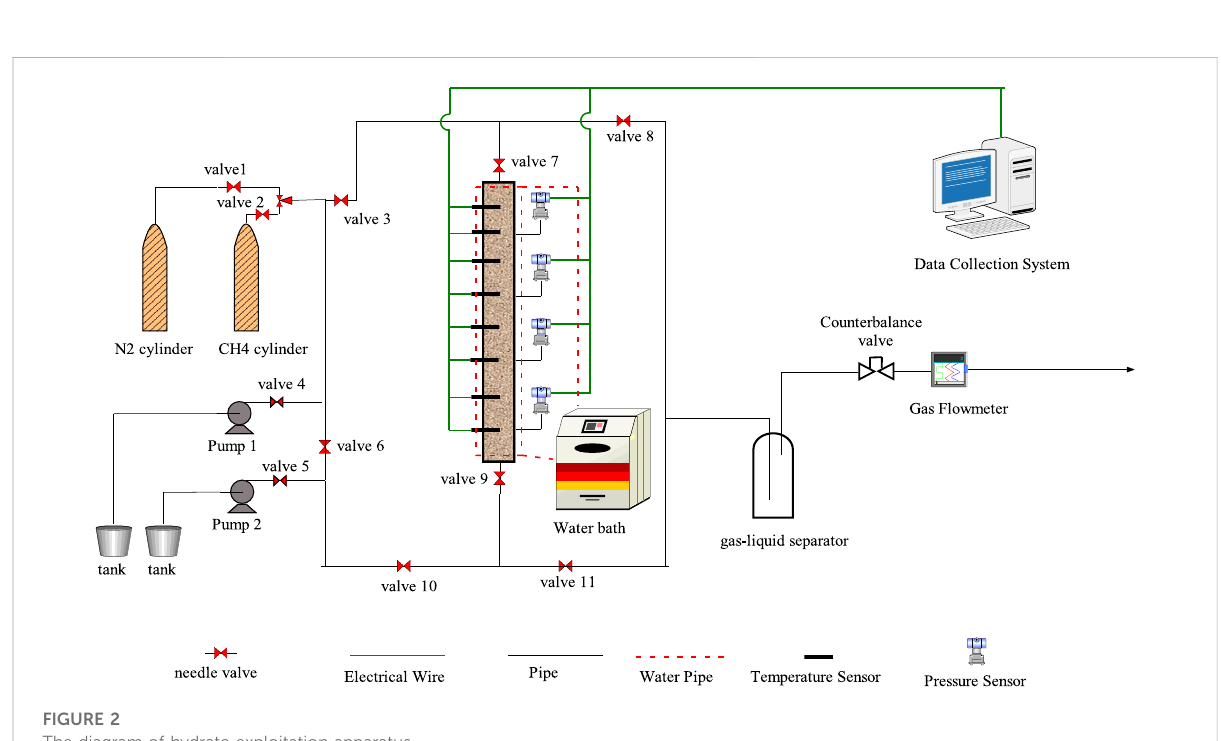
FIGURE 2 The diagram of hydrate exploitation